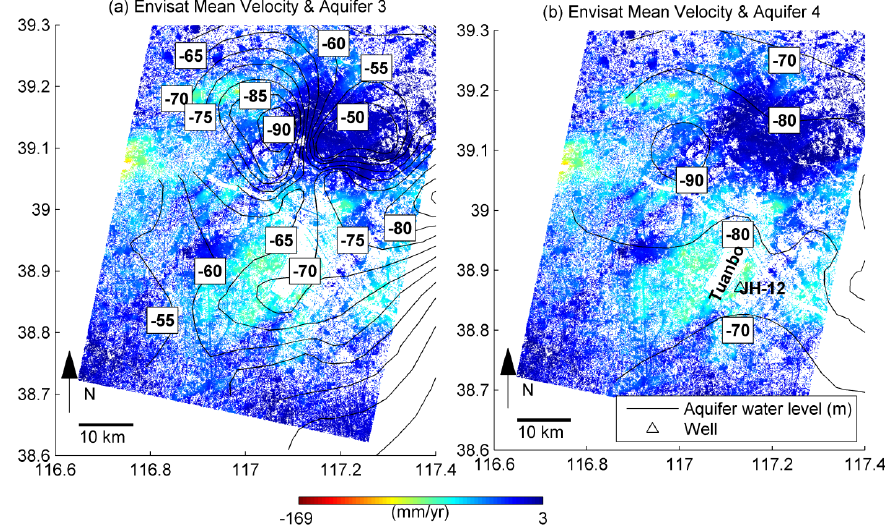
Figure 12. Water levels in 2008 superimposed on LOS subsidence rates from Envisat (4 January 2008 to 12 June 2009): ( a ) Aquifer III; and ( b ) Aquifer IV. Location of JH-12 Well is marked in triangle. Tuanbo Reservoir is labeled.